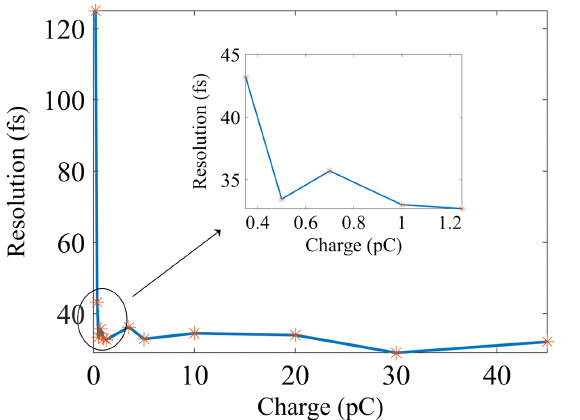
FIG. 16. BAM resolution dependence on the